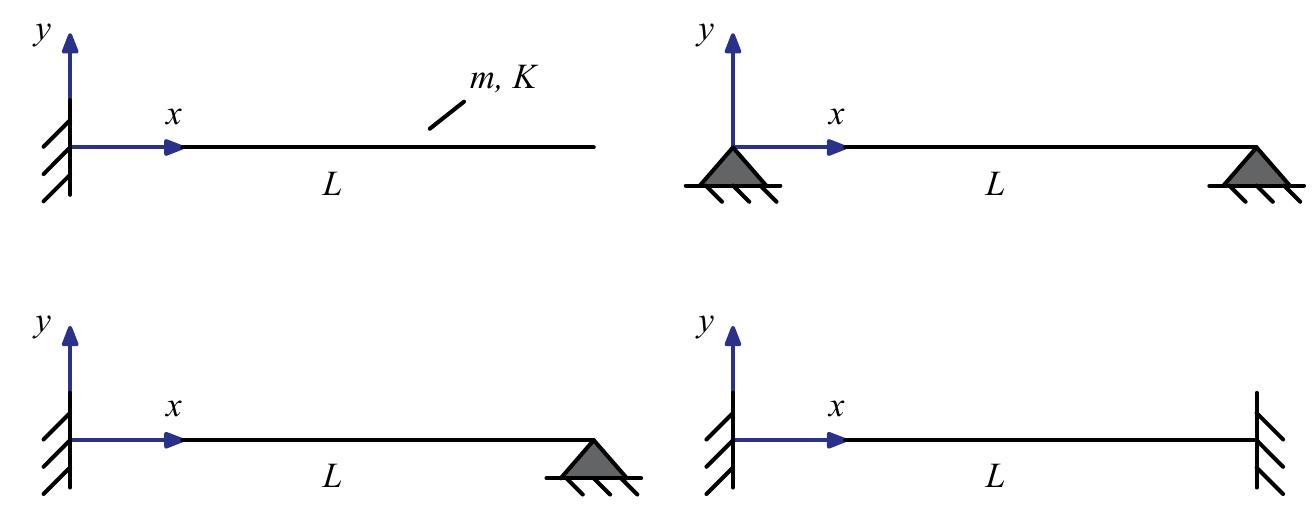
Figure 1. Geometric sketches of adopted structural schemes.